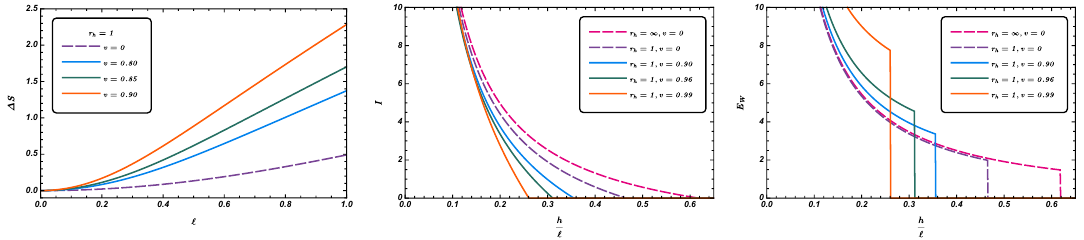
Figure 2 . Subtracted HEE (left), HMI (middle) and EWCS (right) as functions of the width and separation between subregions for different values of r h and v in d = 3